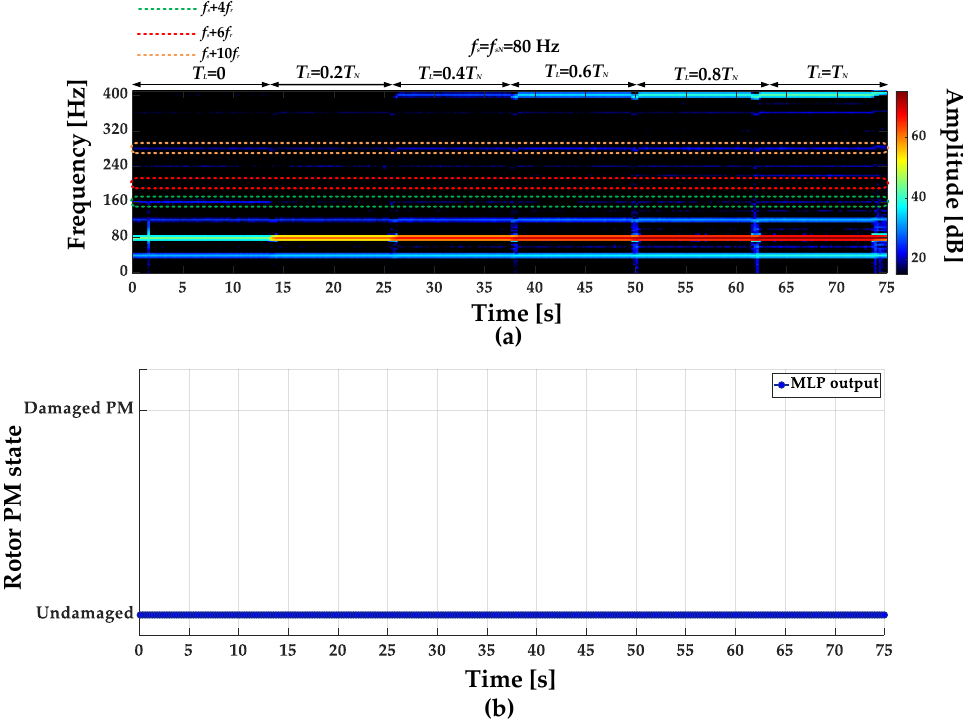
Figure 21. ( a ) Part of the stator phase current STFT spectrogram, ( b ) response of the MLP-based fault detector for undamaged rotor ( T L = var, f s = 80 Hz).